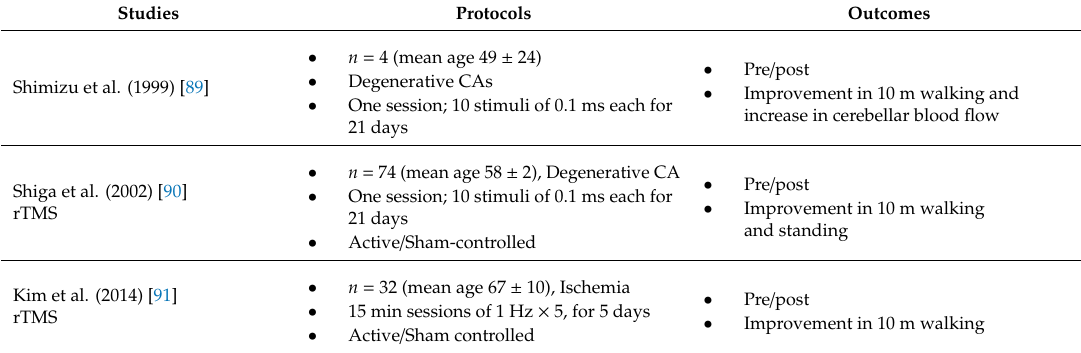
Table 4. Protocols and outcomes of noninvasive cerebellar